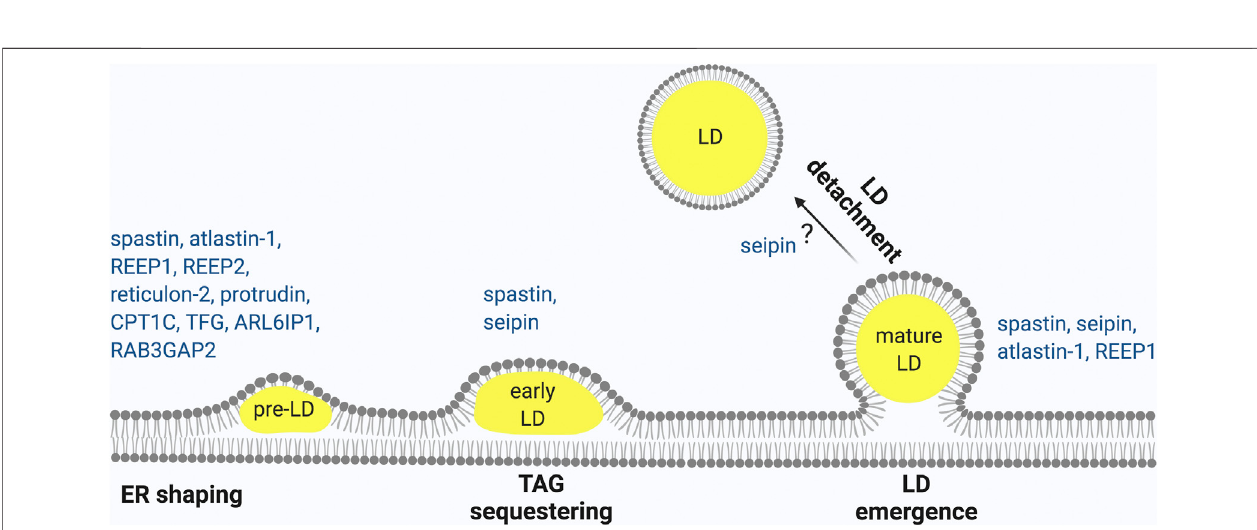
FIGURE 1 | HSP proteins involved in different steps of LD biogenesis. LD biogenesis progress occurring at the ER as shown from left to right. (1) ER morphogens regulate membrane curvature required to initiate LDbiogenesis. (2) Neutral lipid accumulates between the two lea fl ets of the ER to form nascent LDs that (3) continue to expand to early LDs (4) and fi nally lead to mature LDs that (5) may undergo detachment from the ER. HSP-associated proteins involved in each of these steps are indicated. Made with